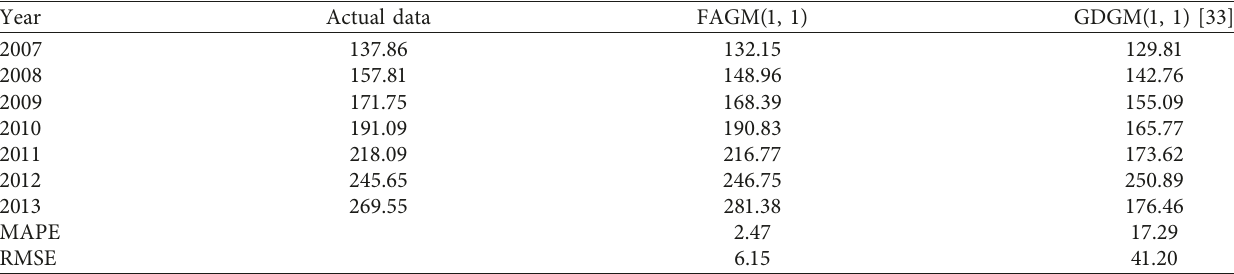
Table 5: The forecasting results of two models: Case 3.